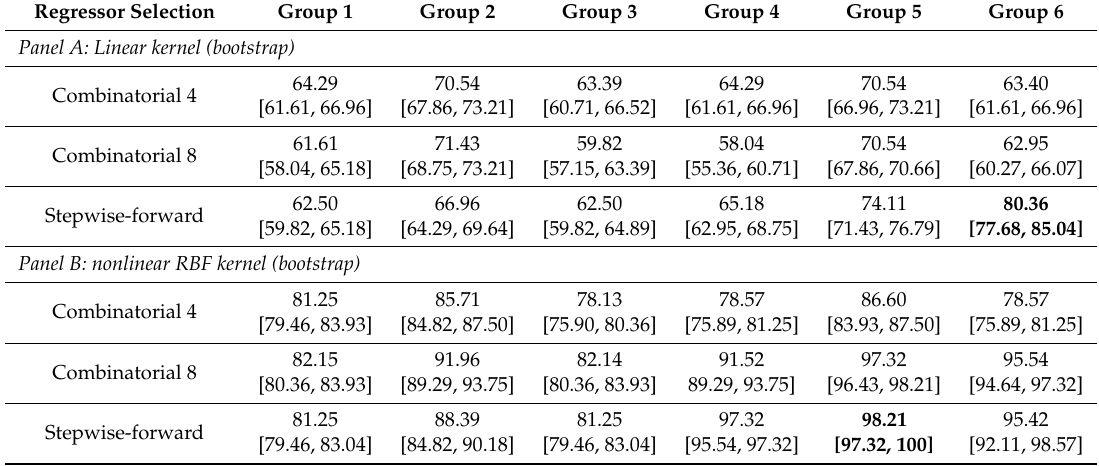
Table 10. Bank Rating forecasting accuracy by the SVM model (%).